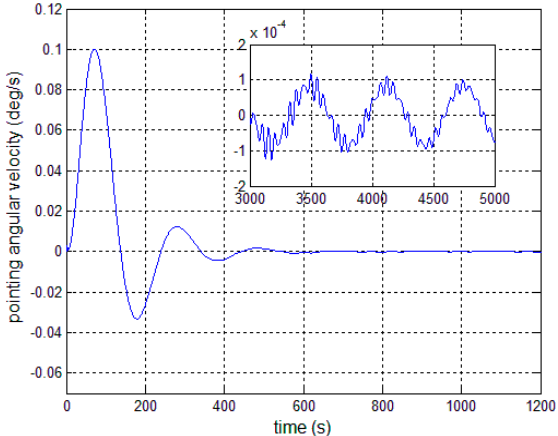
Figure 8. Antenna pitch angle error—controller, Equation (23).